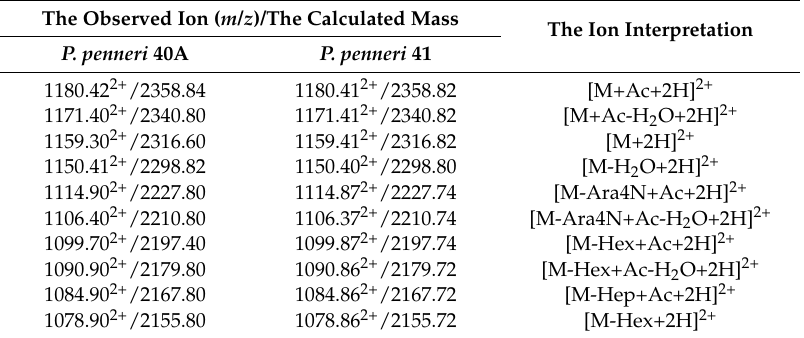
Table 1. ESI MS data obtained for the core oligosaccharides of P. penneri 40A and 41.